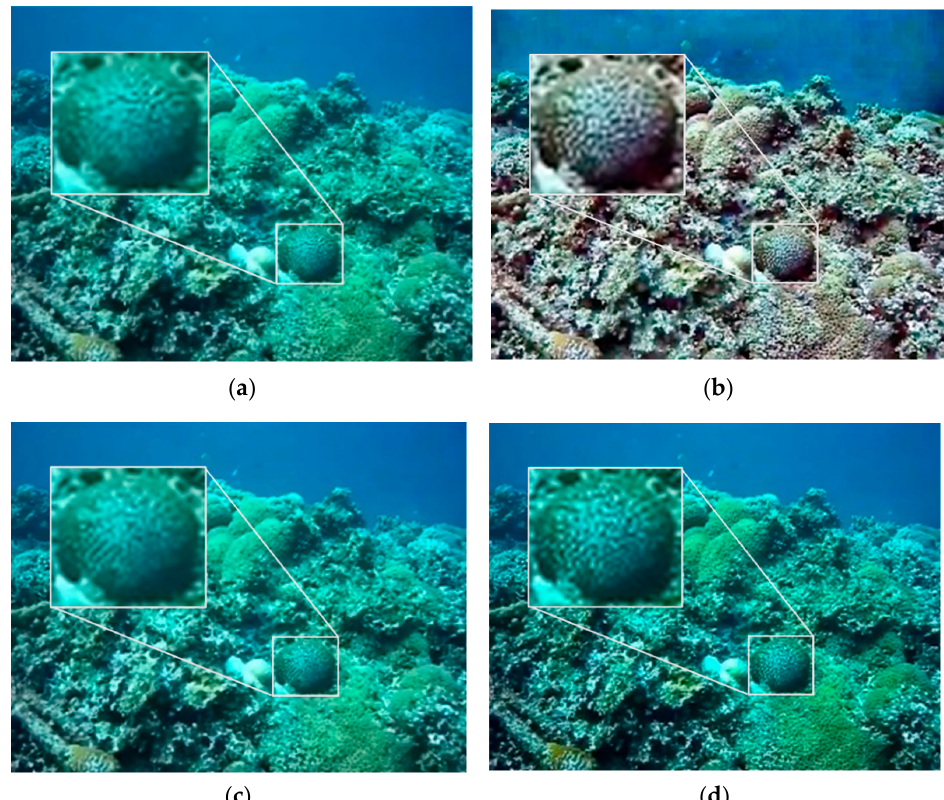
Figure 5. Test 1 image enhancement results. ( a ) Original image; ( b ) CLAHE; ( c ) MF; ( d ) DCP.